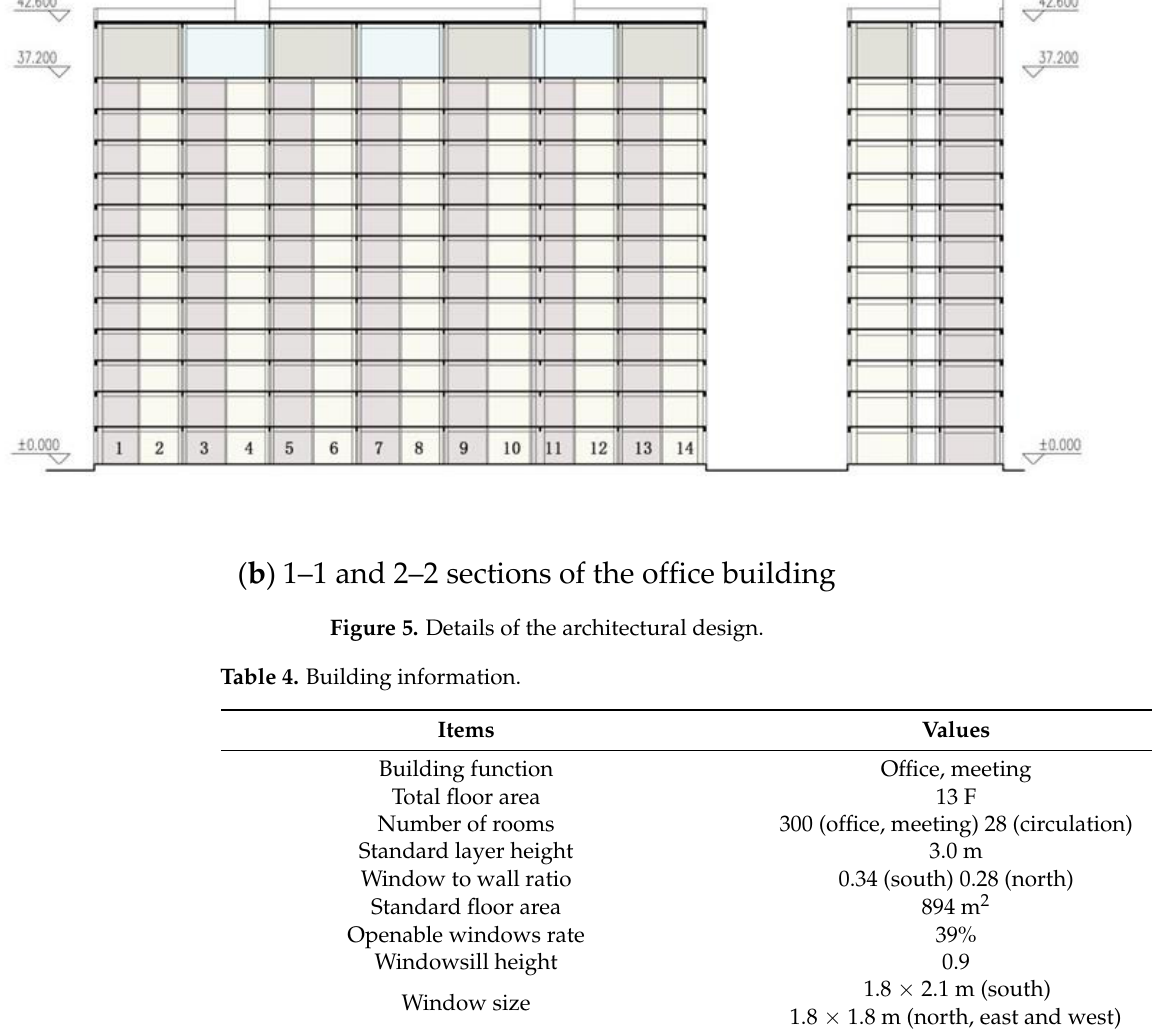
Table 5. Details of roof, external wall, and ground design.